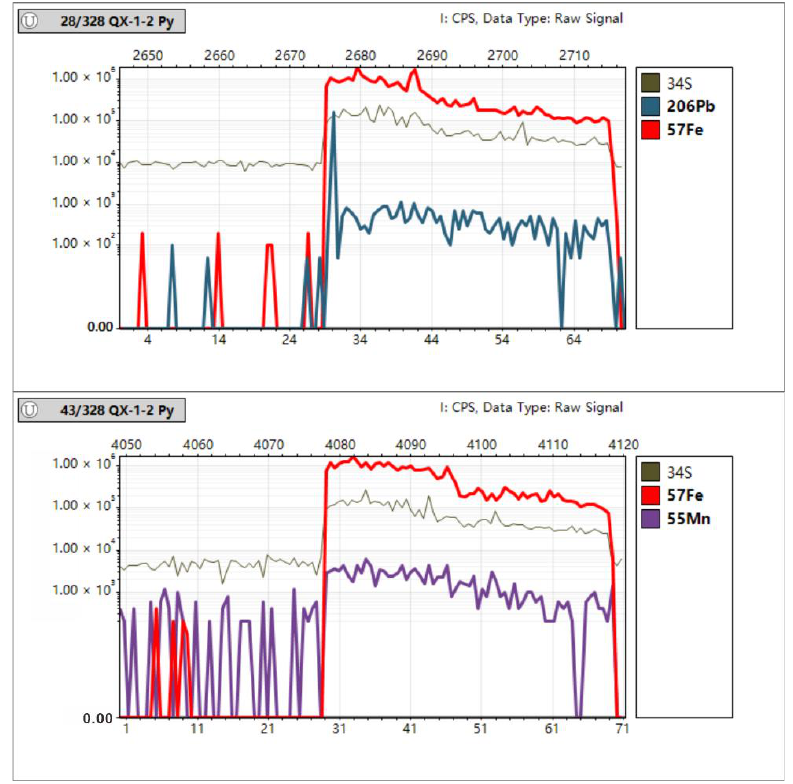
Figure 12. Time-resolved depth profiles of Pb and Mn in Sample QX-1.